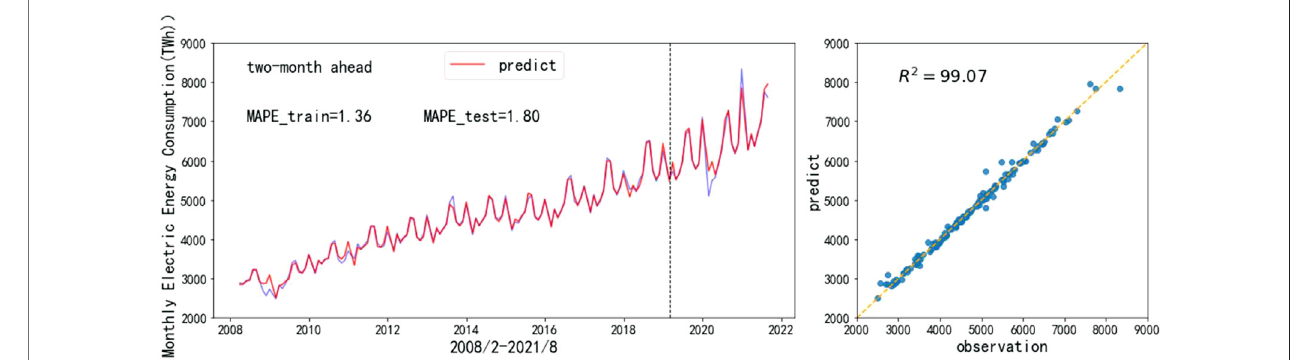
FIGURE 10 | STL-SARIMA-TCM-RM for 2-month ahead forecasting.